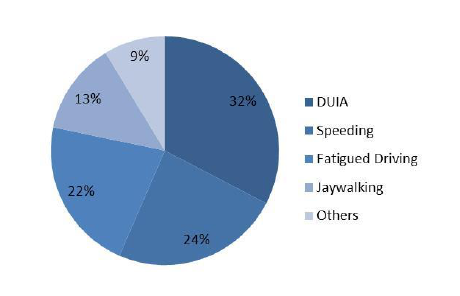
Figure 1: Proportional composition of road crashes